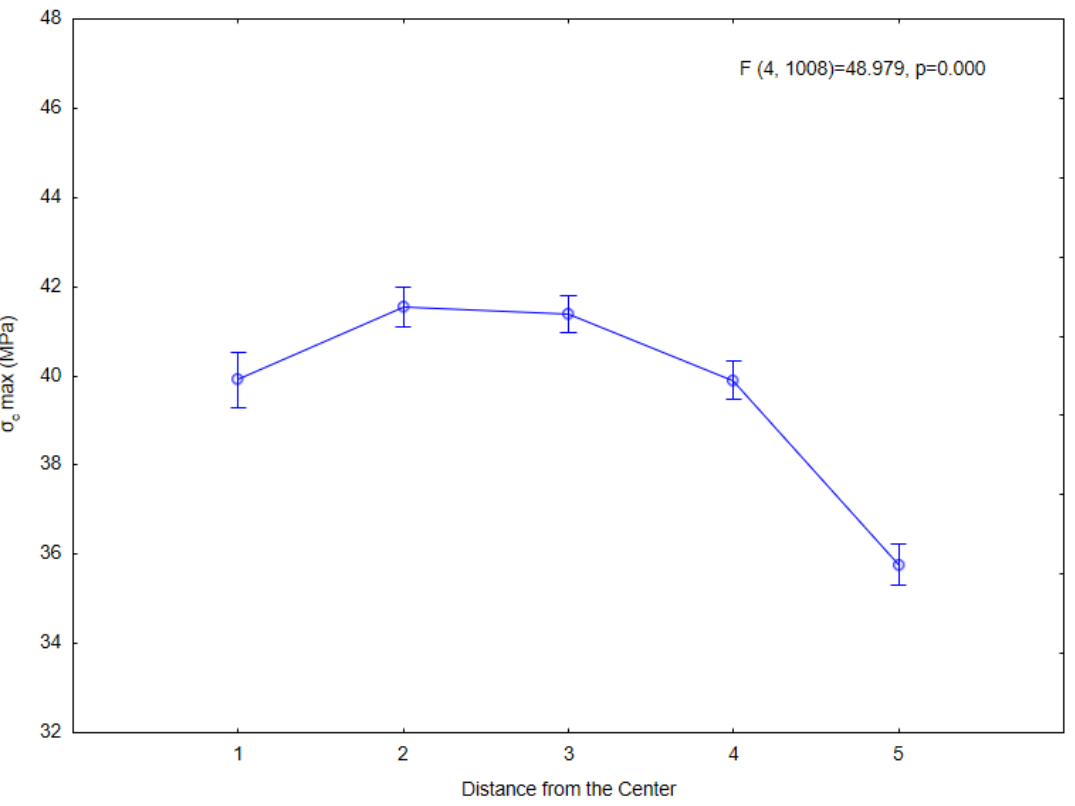
Figure 8. Statistical evaluation of the effect of distance from center on compressive strength using ANOVA.